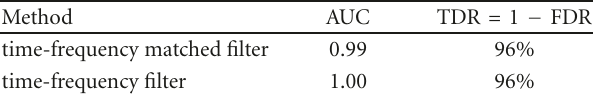
Table 3: Detection results using newborn